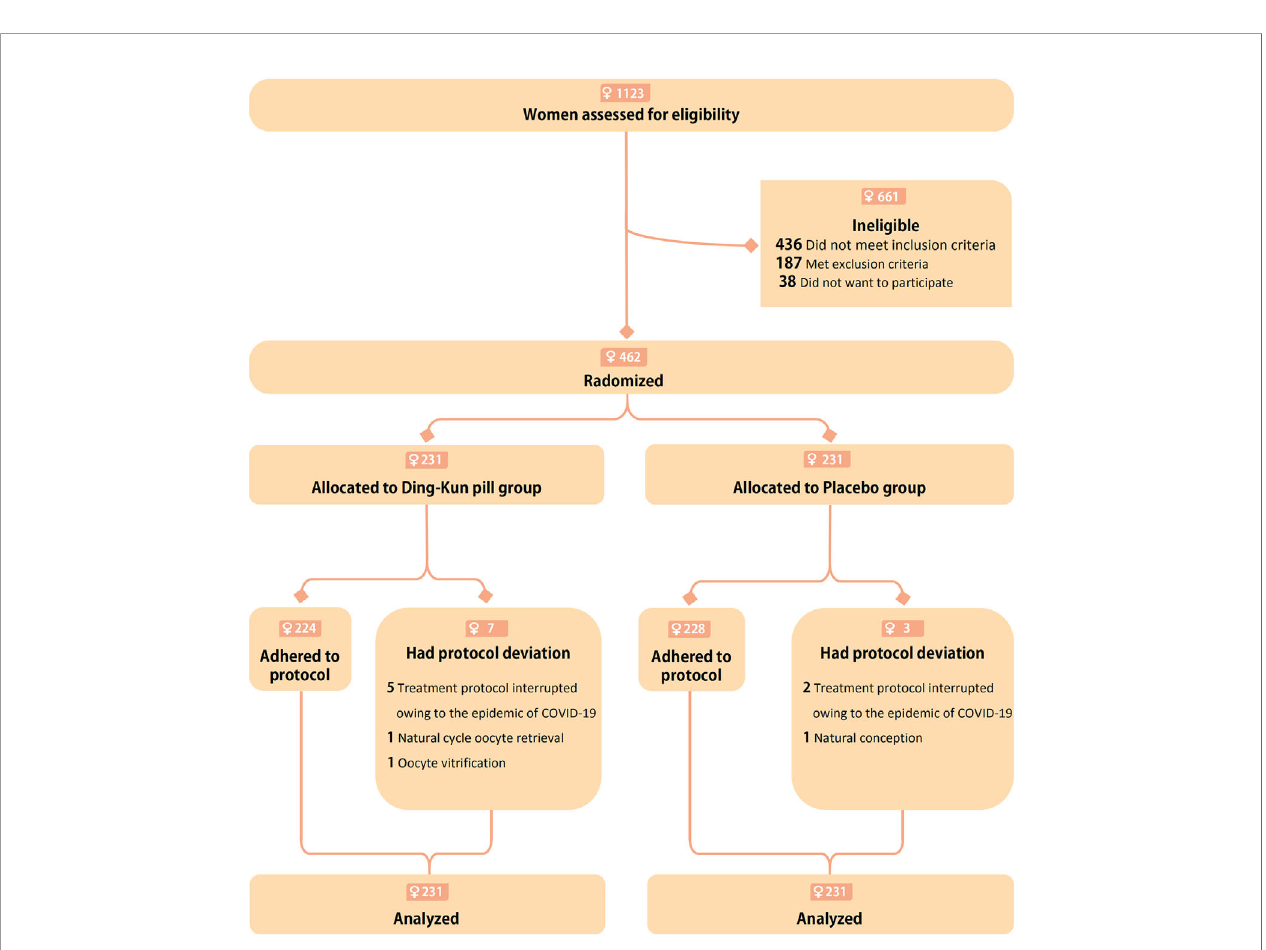
FIGURE 2 | Flow chart depicting the randomized assignment of women to the Ding-Kun Pill and Placebo groups, exclusions, and protocol deviations.